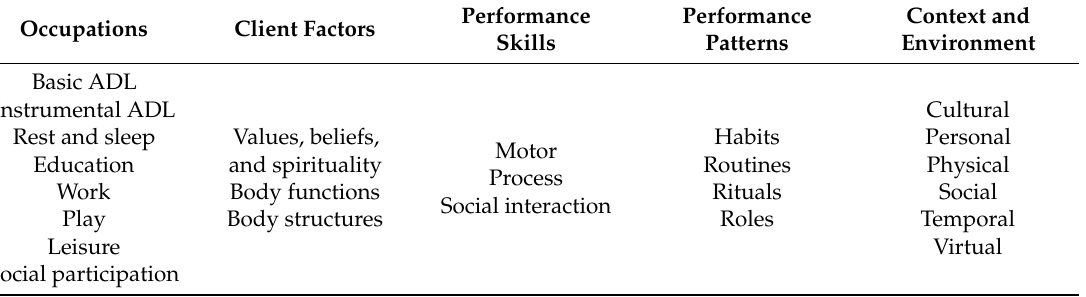
Table 1. Aspects of the domain of occupational therapy